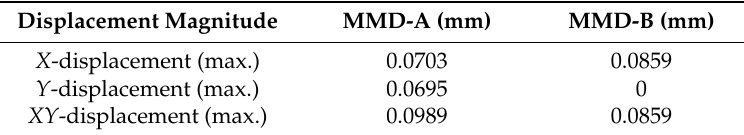
Table 4. The predicted mandrel deflections in one case of die configurations.